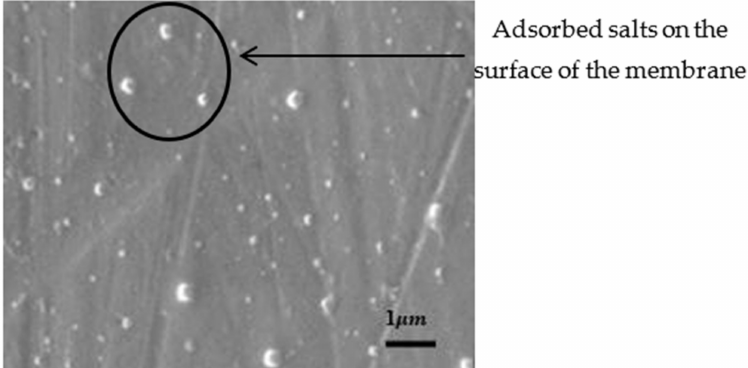
Figure 17. SEM image of membrane with lower graphene–chitosan levels. Reprinted from [42]. Copyright 2018 with permission from Elsevier.